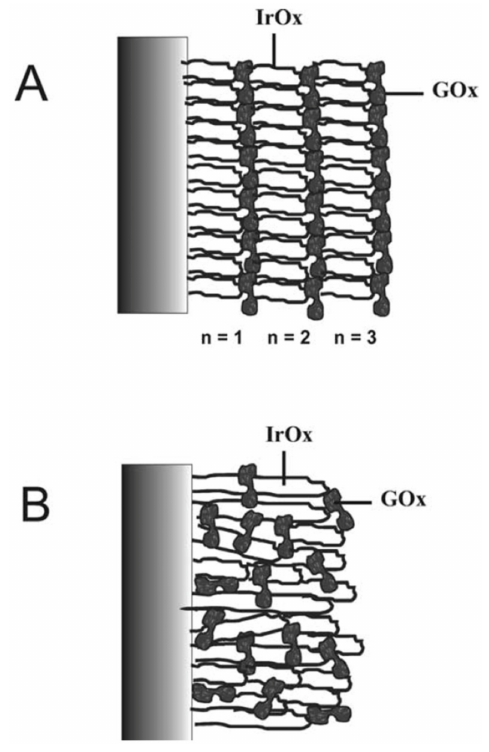
Figure 3. Schematic diagram showing the desired structures of IrOx/GOx in both Type A and Type B electrodes. Reprinted with permission from reference [16]. Copyright 2002 Elsevier Science